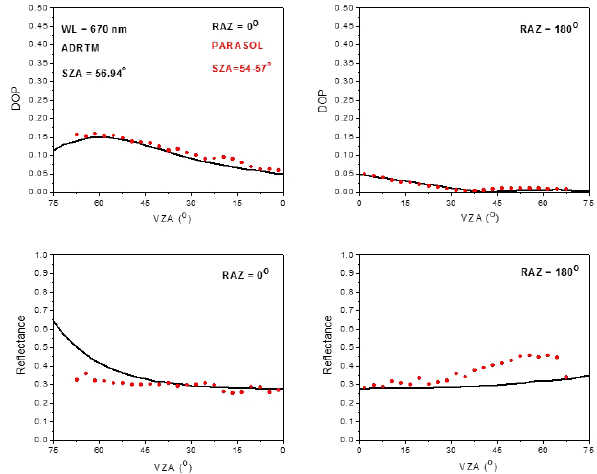
Figure 11. Comparison of the modeled DOP and reflectance of desert-reflected solar light at RAZs of 0 and 180 ◦ with those from the PARASOL data at the wavelength of 670nm. The SZA is 56.94 ◦ in the modeling. The SZA is in the bin of 54–57 ◦ for the PARASOL